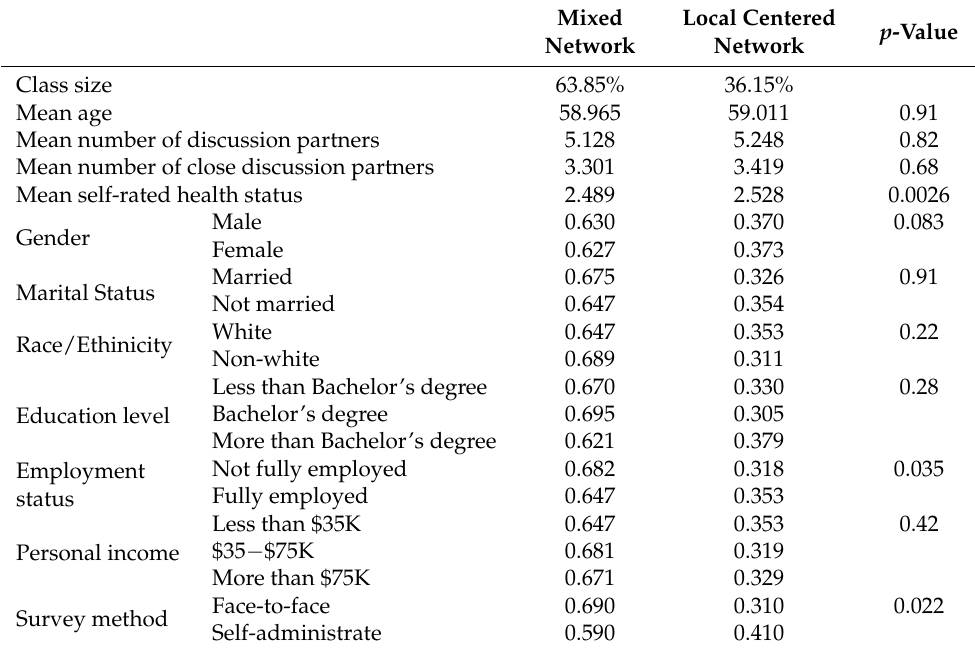
Table 2. Proportion of respondents’ characteristics by discussion network types.